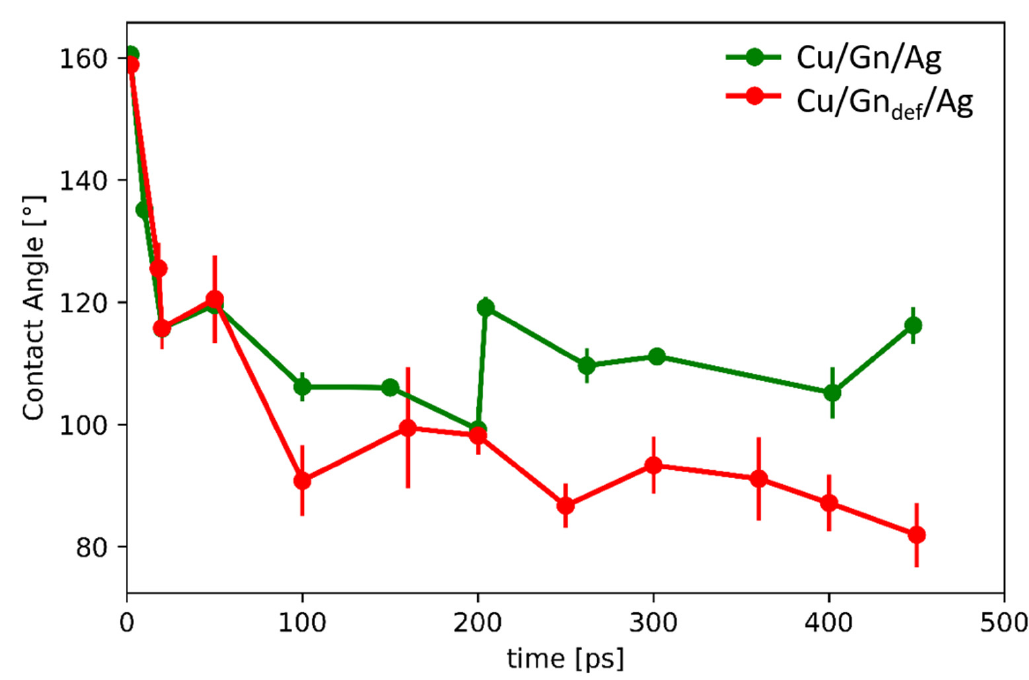
Figure 5. Time evolution of contact angle for Cu/Gn/Ag (green line) and Cu/Gn def /Ag systems (red line).